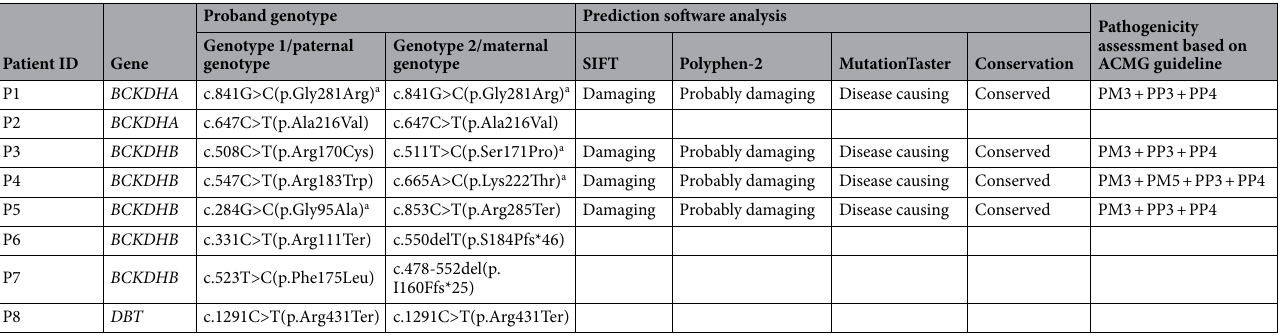
Table 2. Detection and analysis of gene variants in 8 MSUD families. a Novel